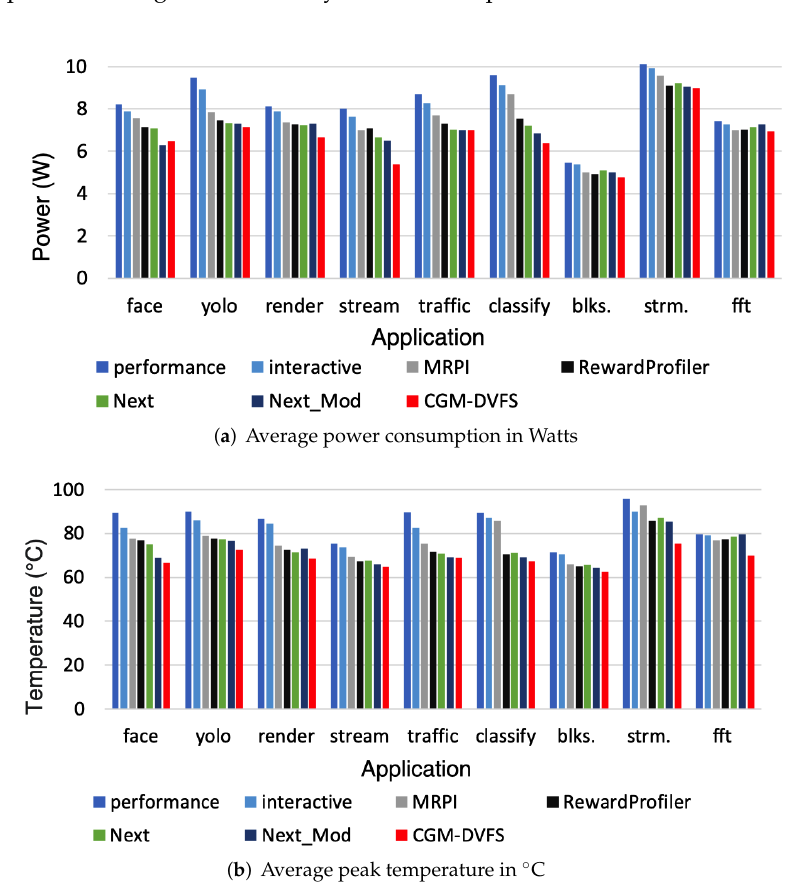
Figure 4. Average power consumption (Watts) and average peak temperature ( ◦ C) when executing different applications on different methodologies: performance, interactive, MRPI, RewardProfiler, Next, Next_Mod and